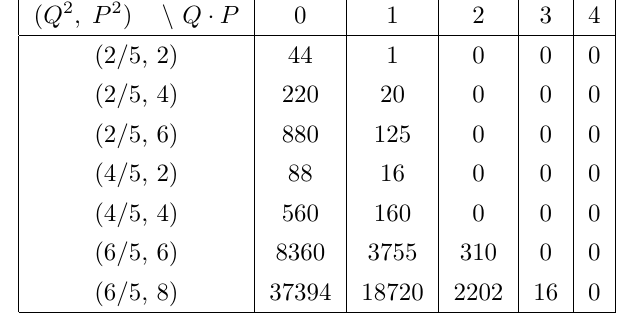
Table 8 . Index of horizon states for the 5 A orbifold of K 3